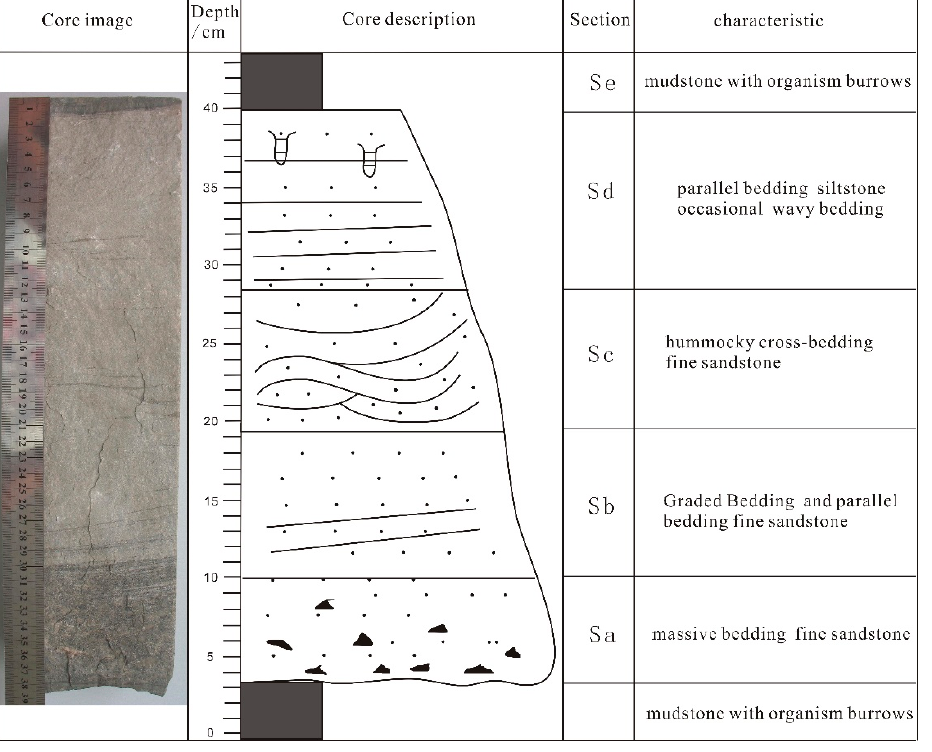
Figure 5. Characteristics of storm sediment sequence of Qingshankou Formation in Daqingzijing Oilfield.